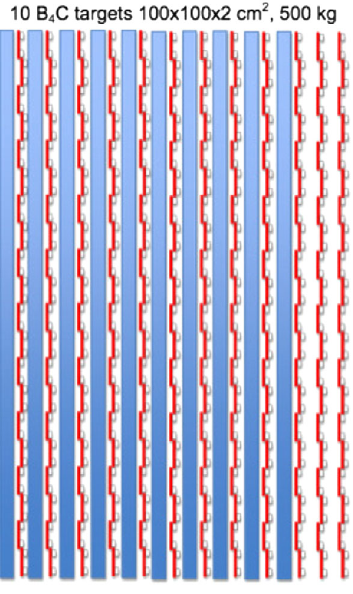
FIG. 18. Conceptual design for a vertex detector at a near detector of a neutrino